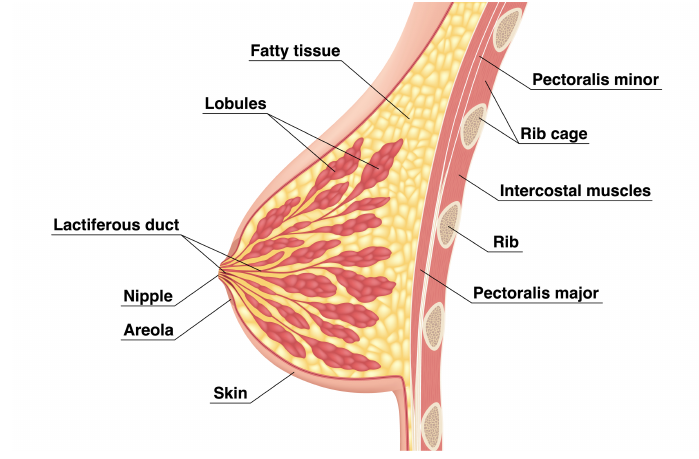
Figure 1. Anatomy of a healthy breast. Image from [14].